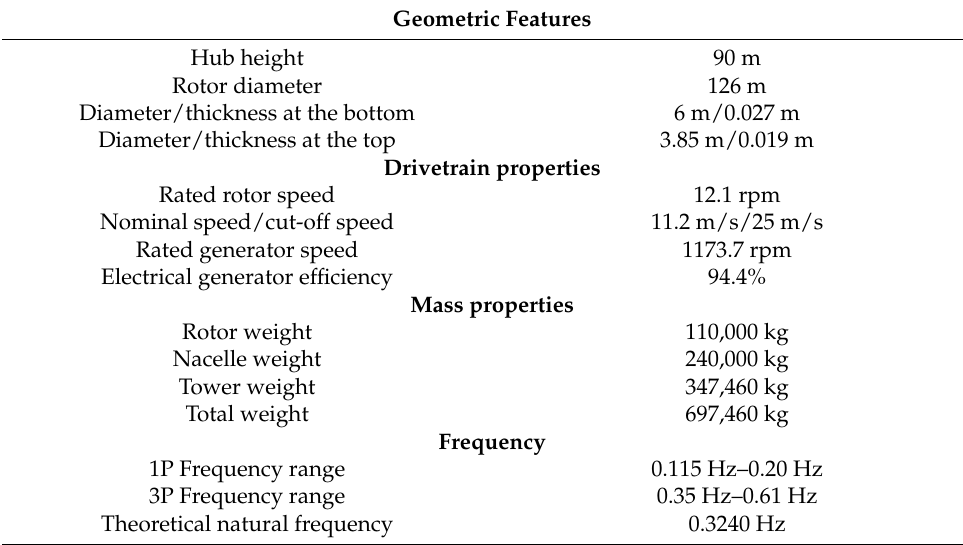
Table 3. NREL-5MW